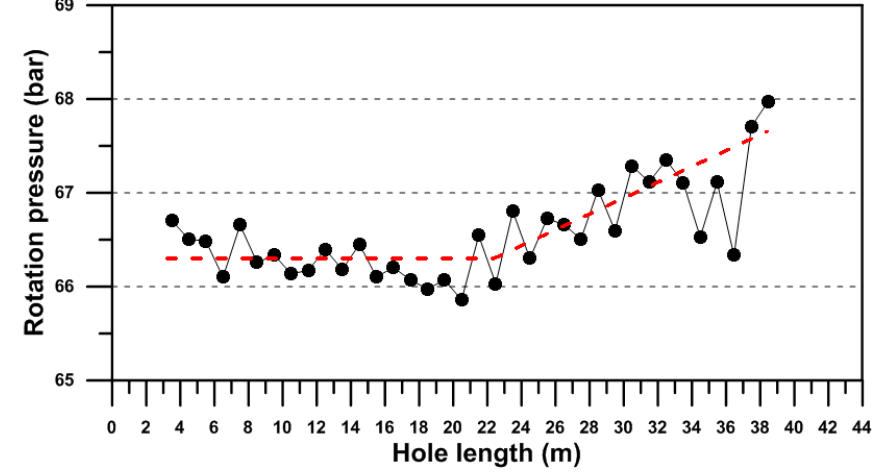
Figure 9. Rotation pressure versus hole length.